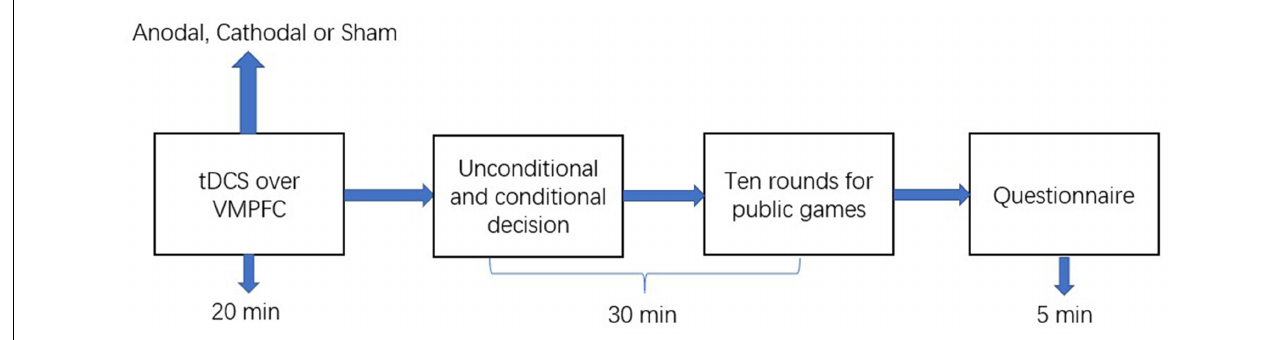
FIGURE 2 | Schematic represent of the experiment design. After 20 min of stimulation, the participant was asked to complete public good or public bad games.